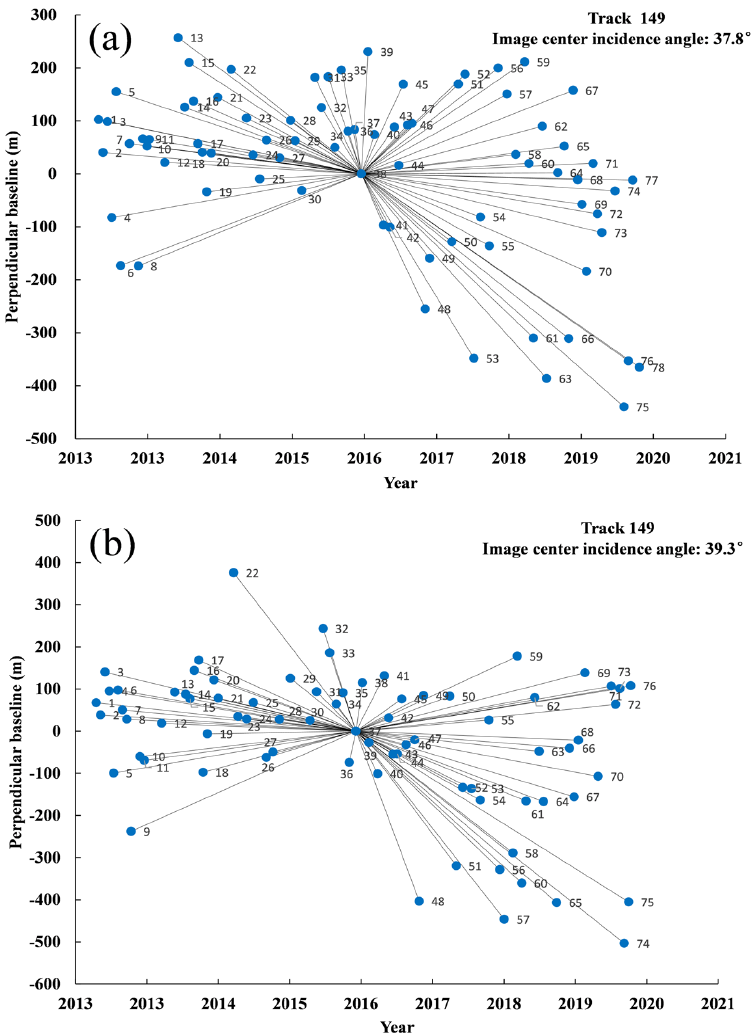
Figure 3. The perpendicular and temporal baselines of TerraSAR-X interferometric image pairs; the blue points represent the SAR images and the black lines represent the interferogram. ( a ) shows the temporal and perpendicular baselines of the interference image pairs (image center incidence angle: 37.8°), ( b ) shows the temporal and perpendicular baselines of the interference image pairs (image center incidence angle: 39.3°).